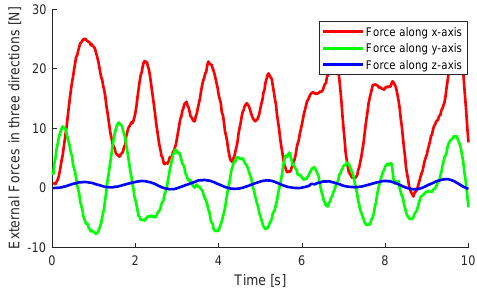
Figure 9. The forces in the x − and y − directions are shown in red and green, respectively. The disturbance in the z − direction (shown in blue) is